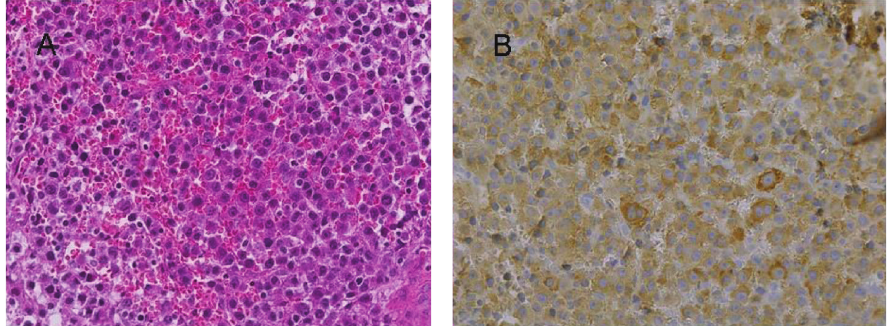
Figure 1: Histological features of the tumor in the 1st lumber vertebra. (A) Dense infiltrates of monomorphic plasma cells were seen (hematoxylin-eosin stain). (B) Plasma cells were positive for immunoglobulin 𝜆 light chain (immunohistochemical stain).